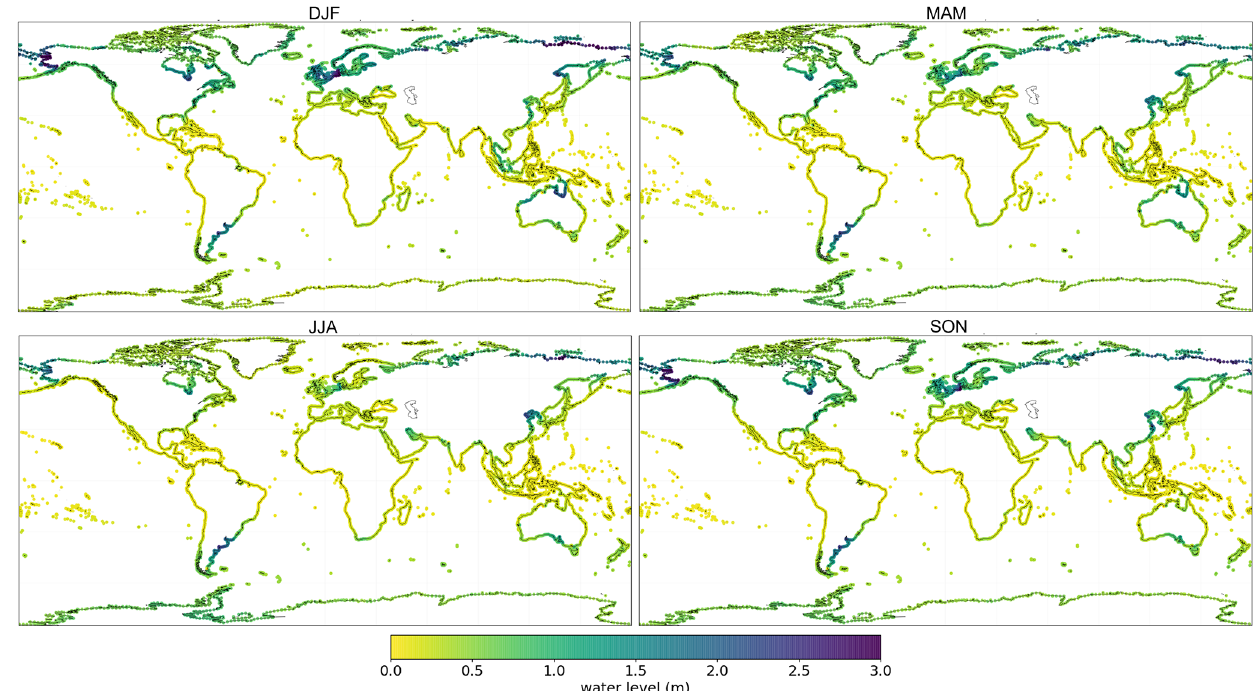
Figure 3. Sea level extremes from storm surges in the LIG simulation at the 10-year return